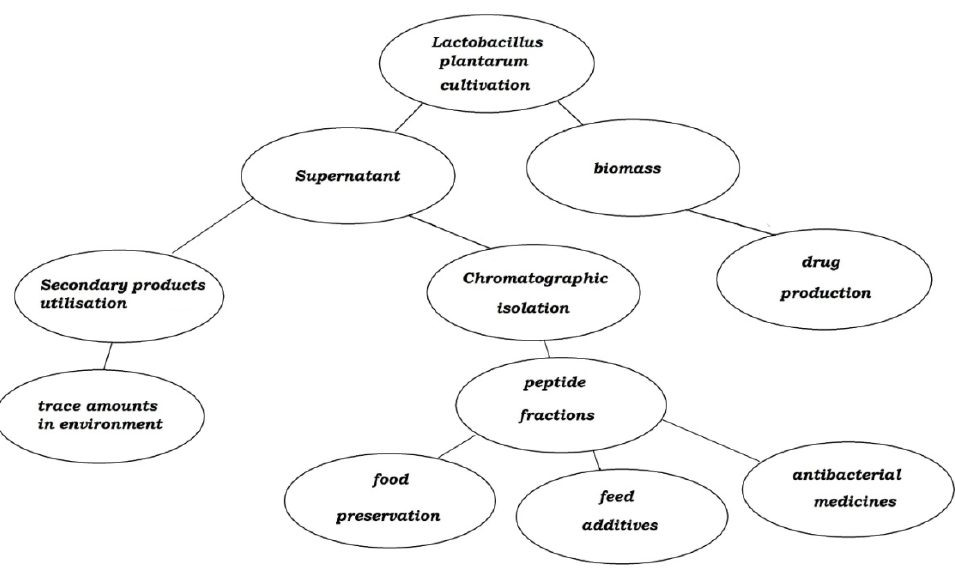
Fig. 1. Lactobacterinum production process flow